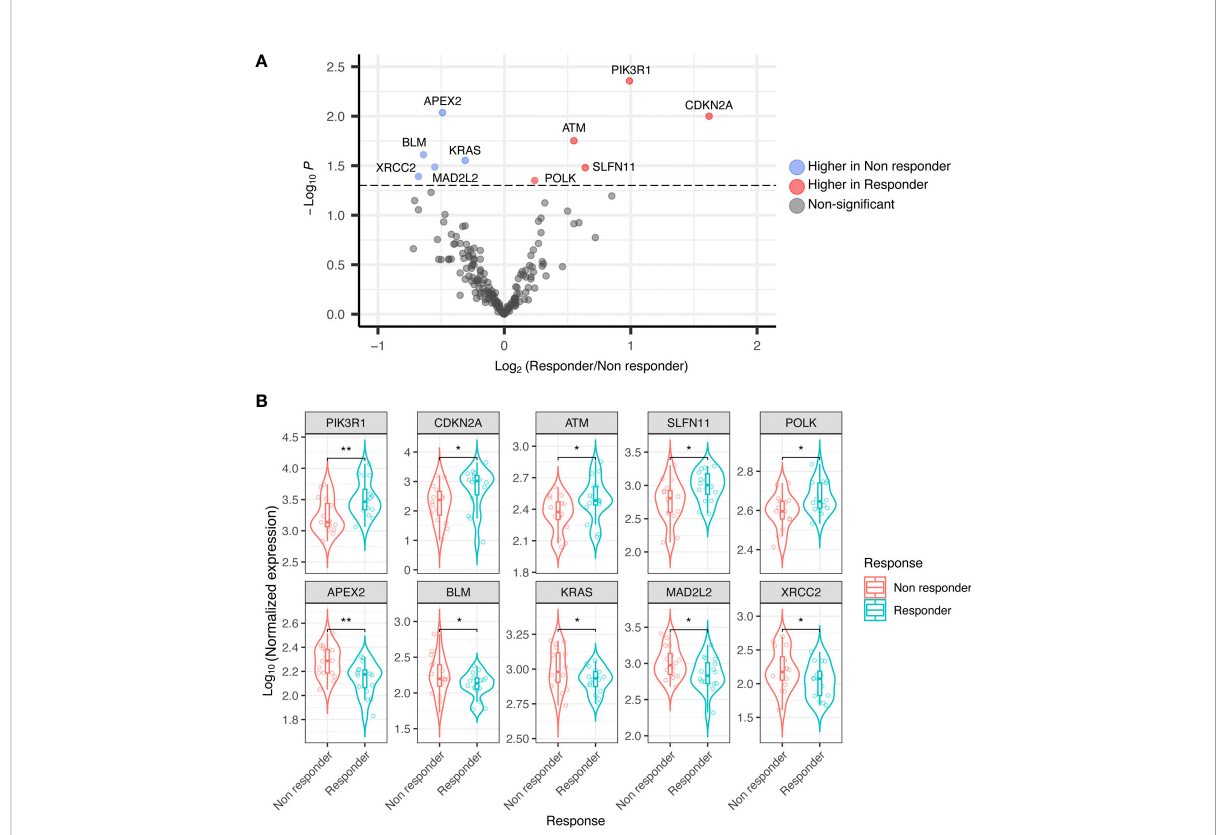
FIGURE 1 (A) Volcano plot showing differential expression of DDRR genes in responder vs. non-responder patients. (B) Boxplot showing differential expression of DDRR genes in responder vs. non-responder patients, with normalized expression. P-value by Wilcoxon Rank-Sum test. *p<0.05; **p<0.01.